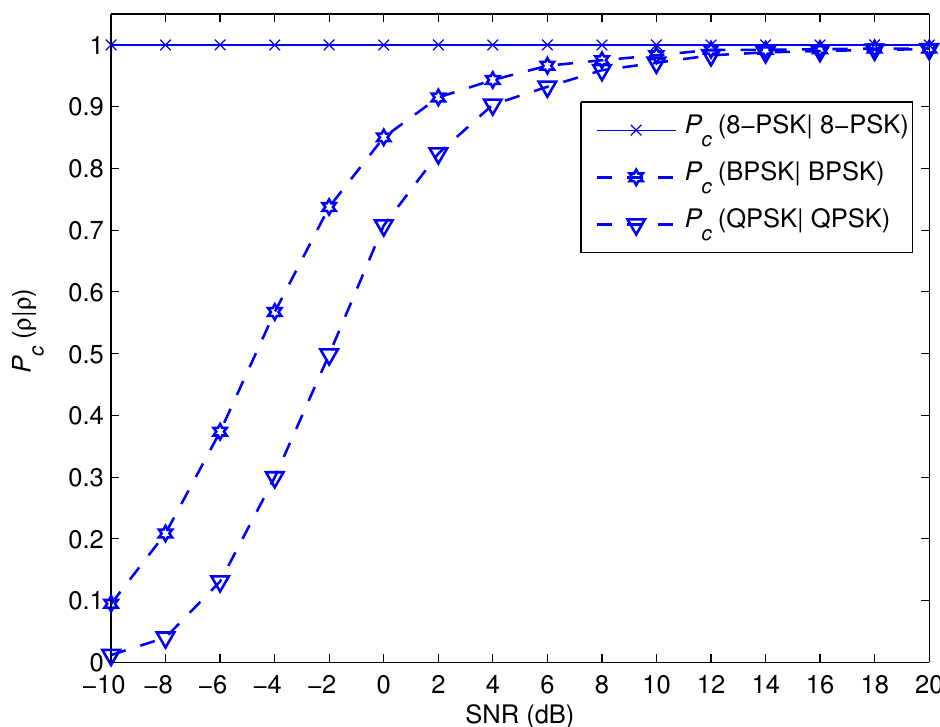
Figure 9. The categorization performance for the modulation set of Ω 2